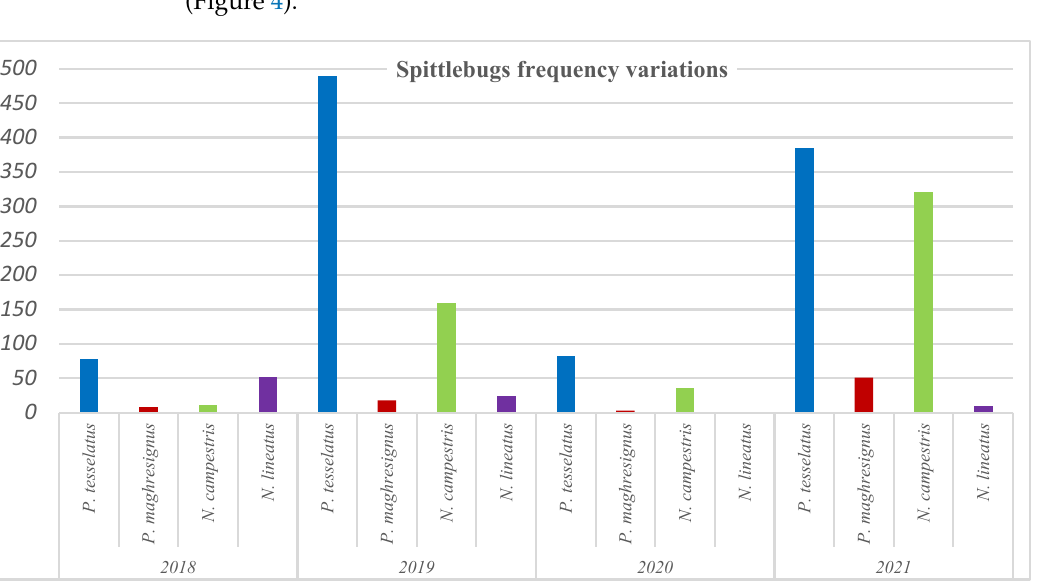
Figure 4. Frequency variations of the four spittlebugs according to year.